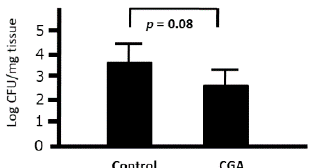
Figure 9. Ex Vivo effects of chrologenic acid (CGA) on the phagocytic activity of intraperitoneal macrophages against Citrobacter in mice. Bacterial colonies at 1 h after the start of phagocytosis were demonstrated. Data are presented as mean ± S.D. ( n = 6). t -test.